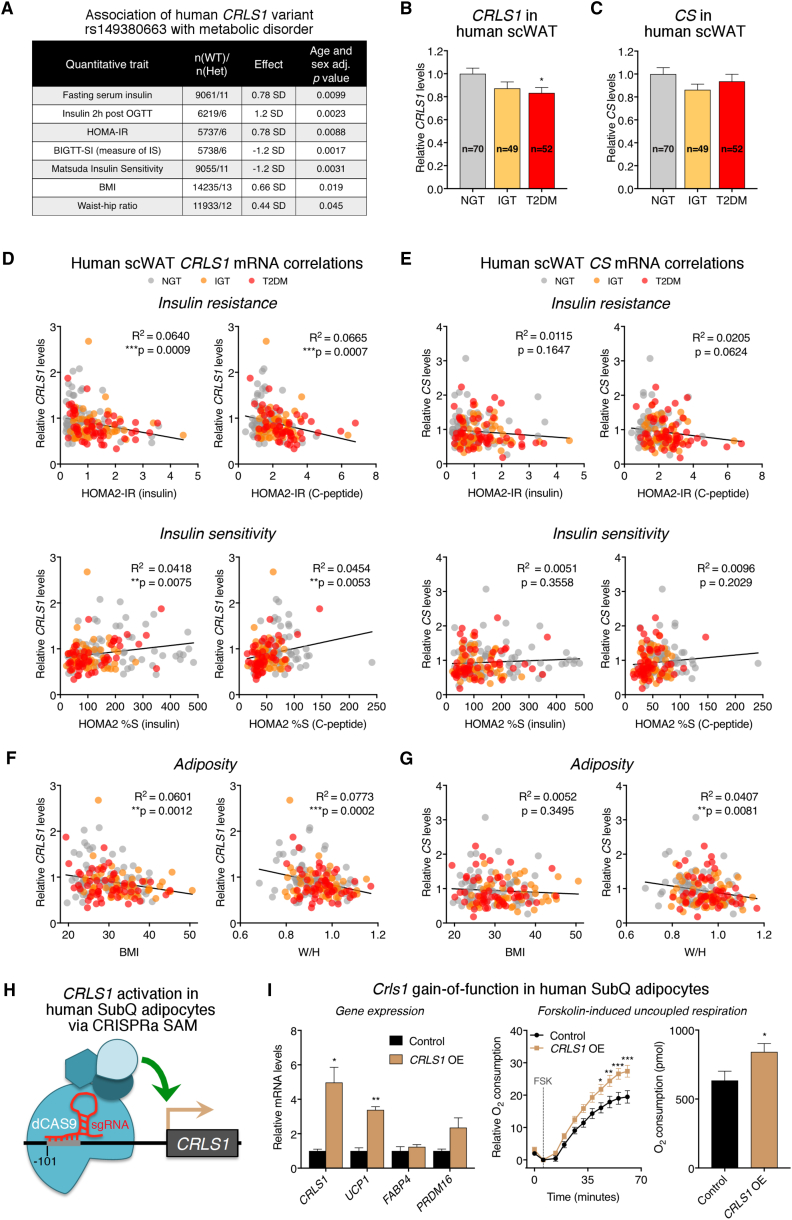
Adipose CRLS1 Is Linked to Whole-Body Insulin Sensitivity in Humans and Augments Human Fat Cell Energy Expenditure(A) Genetic link between a rare CRLS1 variant and metabolic disease from Danish population-based cohorts.(B–G) CRLS1 (B) and CS (C) mRNA levels in the scWAT of normal glucose tolerant (NGT), impaired glucose tolerant (IGT), and type 2 diabetic mellitus (T2DM) donors (n = 70, 49, and 52 per group, respectively, one-way ANOVA). Pearson correlations between scWAT CRLS1 (D) and CS (E) mRNA levels and homeostatic model assessment two insulin resistance (HOMA2-IR, calculated by insulin and c-peptide), HOMA2 insulin sensitivity (%S, calculated by insulin and c-peptide) and adiposity parameters (F and G). Pearson R2 values and significance are shown. W/H, weight/height.(H) Schematic for CRISPRa synergistic activation mediator (SAM) targeting of CRLS1 in human white adipocytes.(I) Gene expression and forskolin (Fsk)-induced respiration (t test) from human white adipocytes transduced with empty vector or vector delivering a single-guide RNA directed to the −101 position upstream of the CRLS1 transcriptional start site. Data are presented as means ± SEM. ∗p < 0.05; ∗∗p < 0.01; ∗∗∗p < 0.001.See also Figure S6 and Table S1.